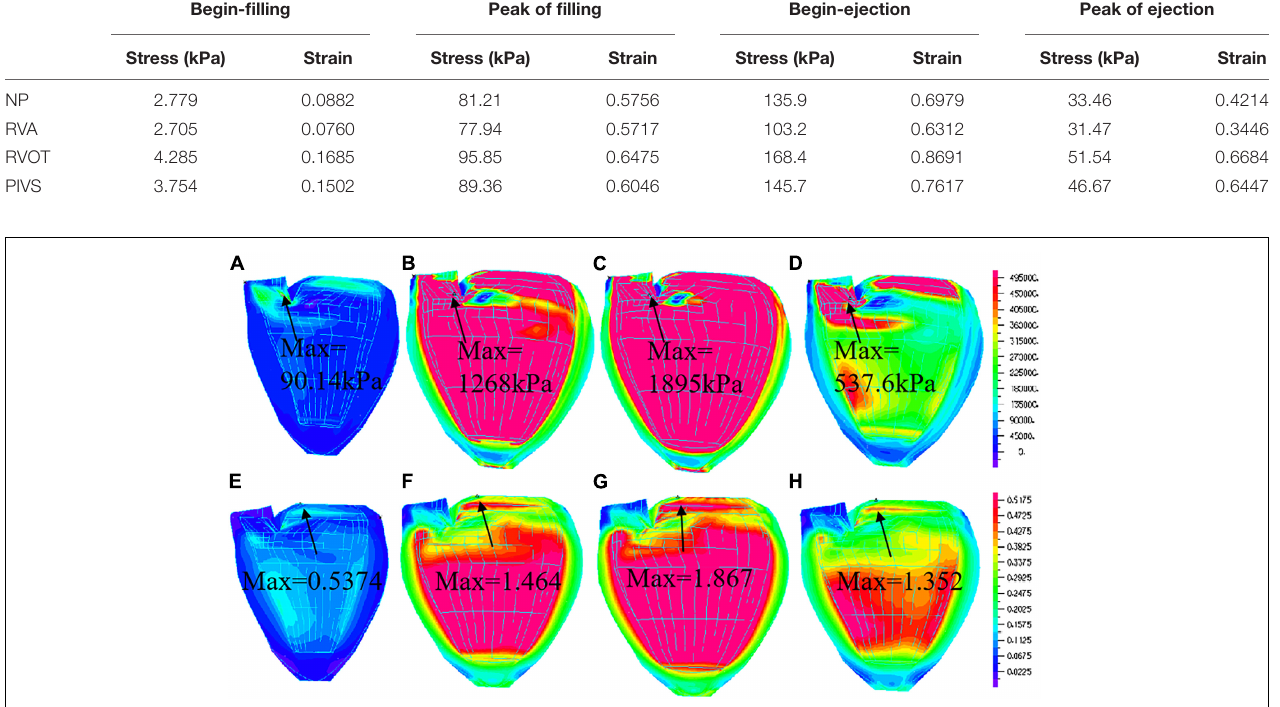
FIGURE 6 | Stress and Strain plots of right ventricular outflow tract (RVOT) model. (A) Stress distribution at begin-filling; (B) . Stress distribution at the peak of filling; (C) . Stress distribution at begin-ejection; (D) . Stress distribution at peak of ejection; (E) . Strain distribution at begin-filling; (F) . Strain distribution at peak of filling; (G) . Strain distribution at begin-ejection; (H) . Strain distribution at peak of ejection.